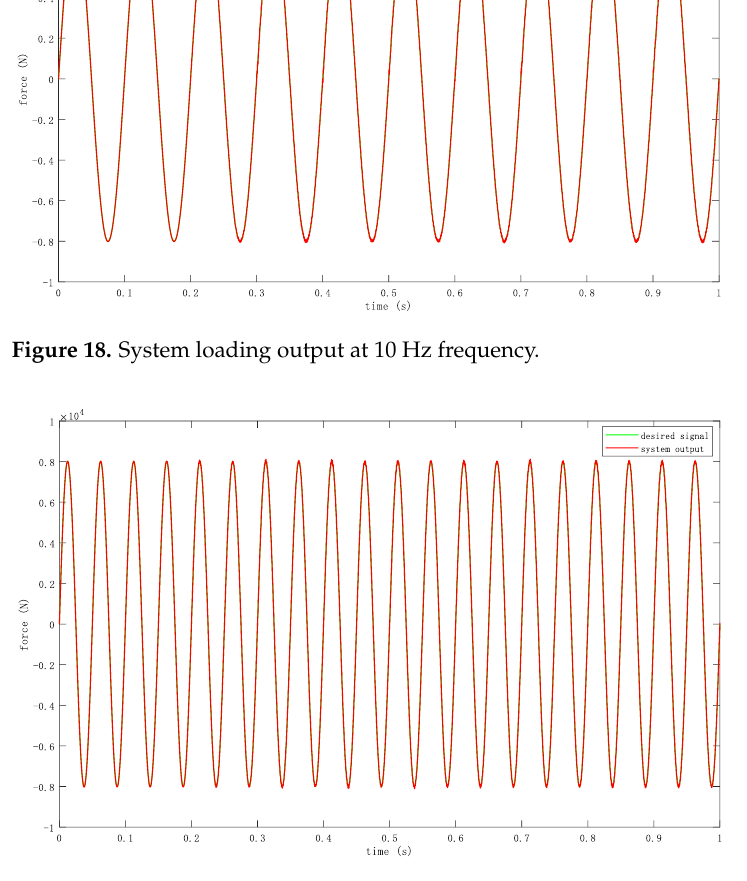
Table 4. System loading error